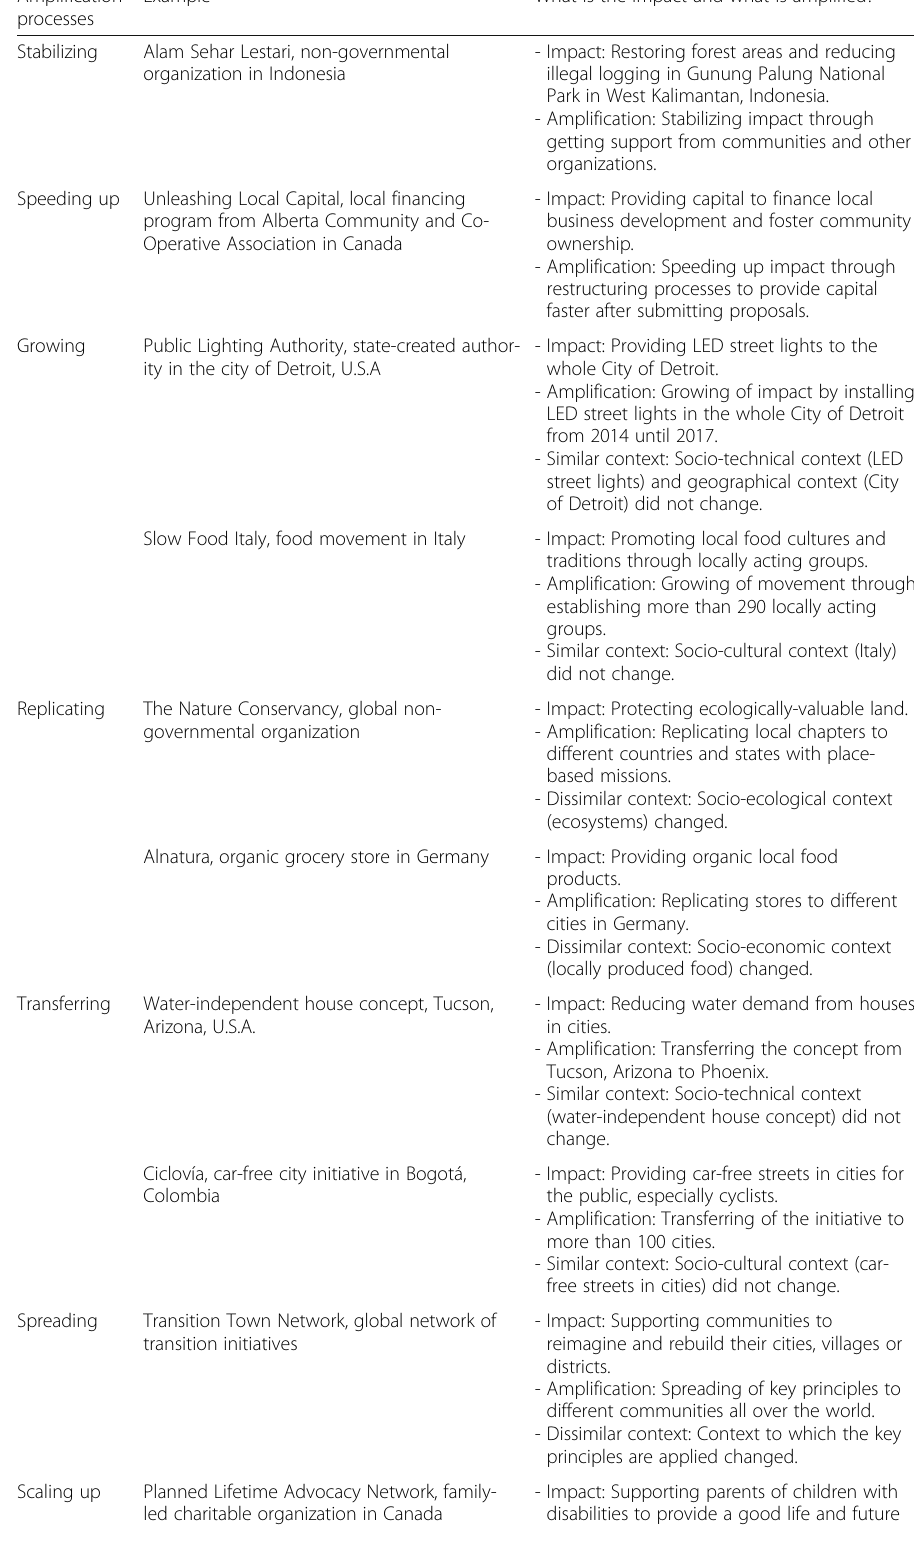
Table 4 Overview of examples that illustrate the amplification processes. For each example, we describe what the impact is and how it is